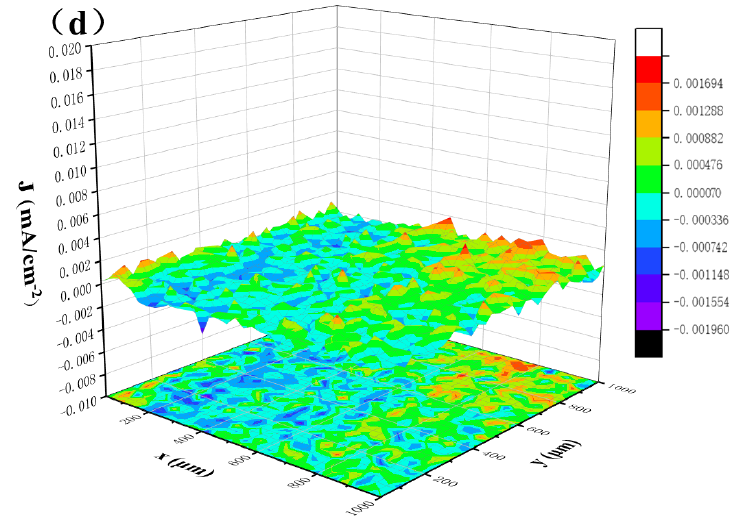
Figure 13. SVET images of copper in acetic acid solution with different concentrations of corrosion inhibitors: ( a ) 0.05 g/L; ( b ) 0.1 g/L; ( c ) 0.5 g/L; ( d ) 1.0 g/L.